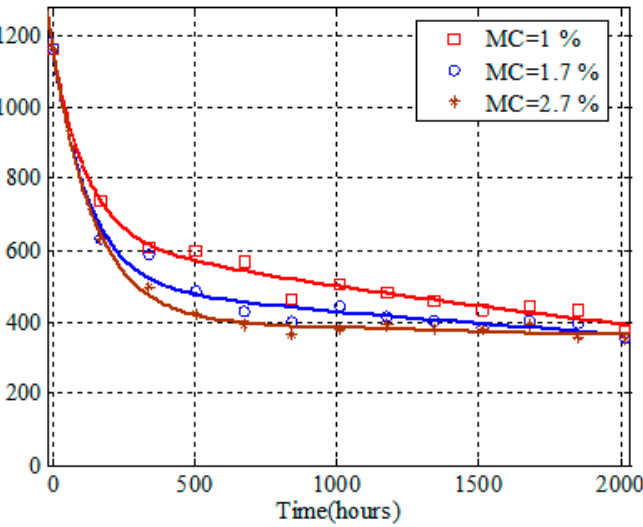
Figure 6. Ageing process at a temperature of 130 ◦ C of NE-immersed paper samples for different initial moisture contents. Fully described in [7]. Reprint with permission [7], Copyright 2017, IEEE.